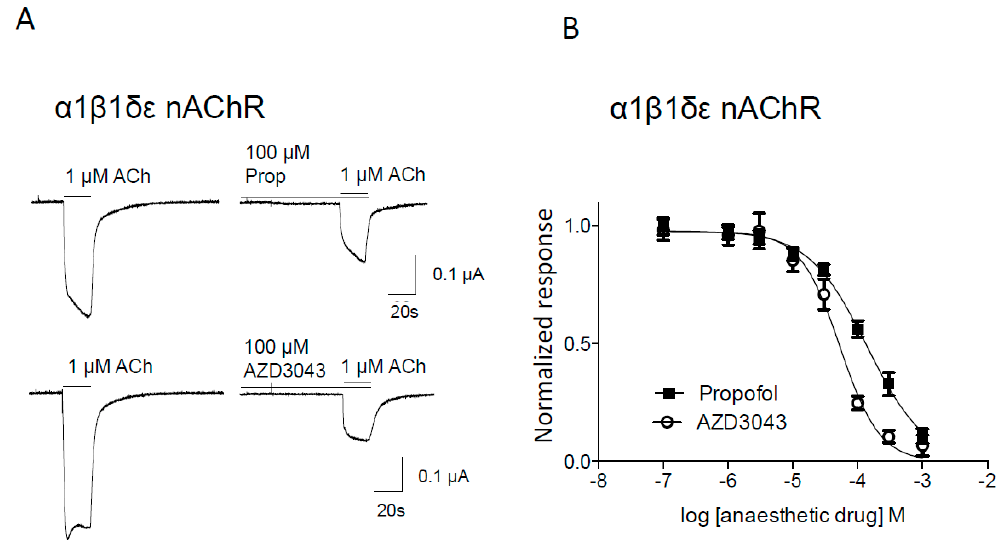
Figure 1. Propofol and AZD3043 concentration-dependently inhibit 1 μ M acetylcholine-induced current responses in Xenopus oocytes expressing the human muscle ( α 1 β 1 δε ) nAChR. Representative traces from one oocyte inhibited by propofol (Prop) respectively AZD3043 ( A ). Concentration-dependent inhibition of currents induced by 1 μ M ACh by propofol and AZD3043 ( B ). Current responses in each oocyte were normalized to the 1 μ M acetylcholine control responses in each oocyte as described in Materials and Methods . Each symbol represents mean ± S.E.M. When no error bars are seen, they are smaller than the symbols. Ach = acetylcholine, Prop = propofol. AZD3043 had a lower IC 50 compared to propofol and was, thus, a more potent inhibitor of the adult muscle nAChR subtype (Table 1). Table 1. Pharmacological properties of propofol and AZD3043 on human nAChRs expressed in Xenopus oocytes.